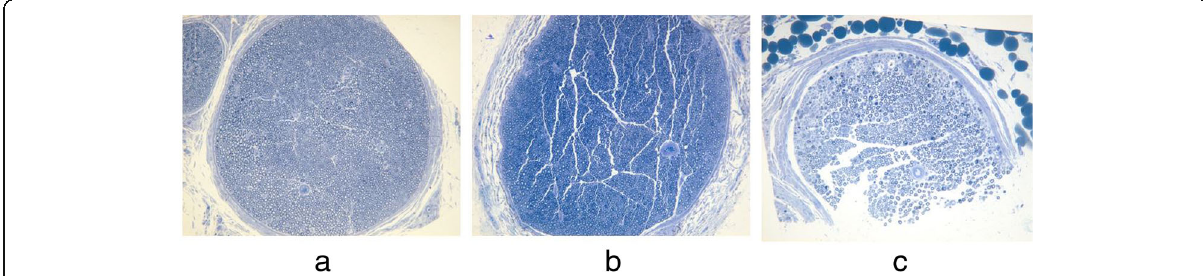
Fig. 5 Cross-sectional photographs showing differential axonal damage of each experimental group with toluidine blue staining of ×100 magnification. ( a intact axons and perineurium of group A, b partial disintegration of axons and perineurium of group B, c moderate damage of axons with disintegration with swollen myelin of group